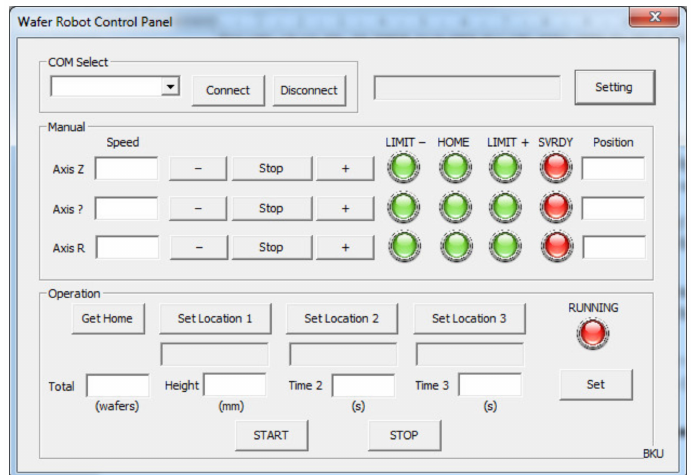
Figure 24. Graphical User Interface